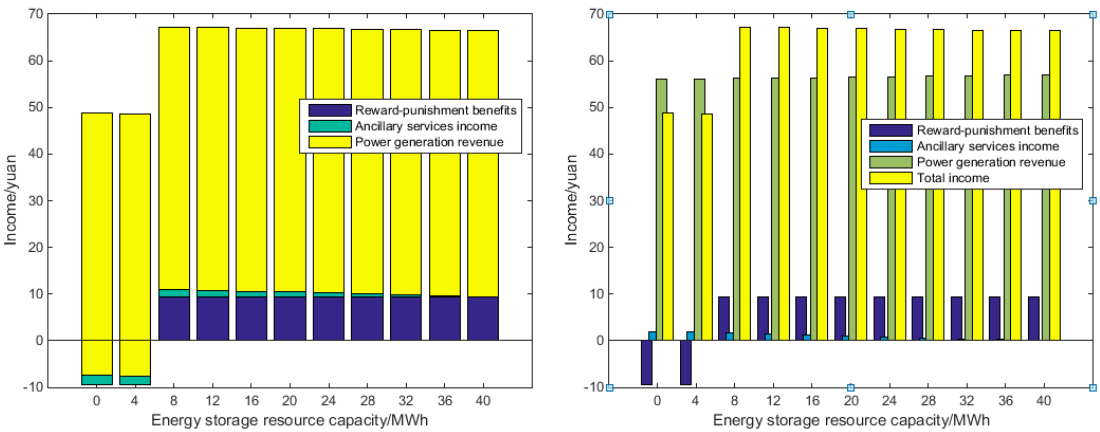
Figure 11. The revenue of VPP of typical scenario